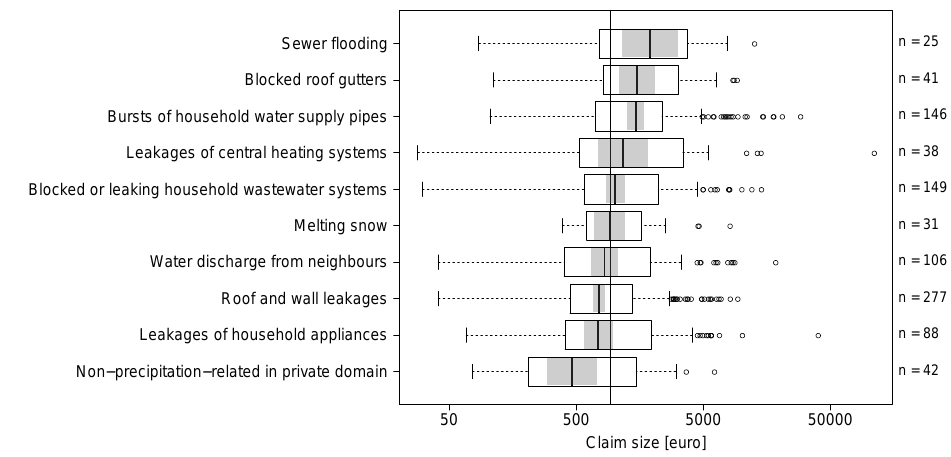
Figure 4. Distribution of claim sizes associated with various failure mechanisms. Claim size is the sum of property and content damage. Only risk addresses are included for which both property and content insurance were available. Results are only shown for failure mechanisms with at least 20 claim records. The grey rectangles display the 95% confidence interval around the median. If the grey rectangles of two boxplots do not overlap, there is a strong indication that the median are statistically different. The vertical solid line represent the median claim size. The number of claims ( n ) within each class are given next to the boxplots.